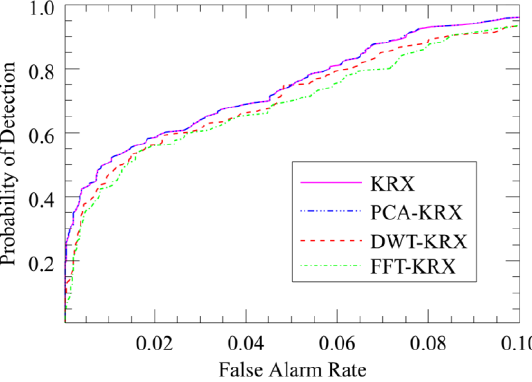
Figure 10. ROC curves of the Kernel-RX AD family for Img-II.